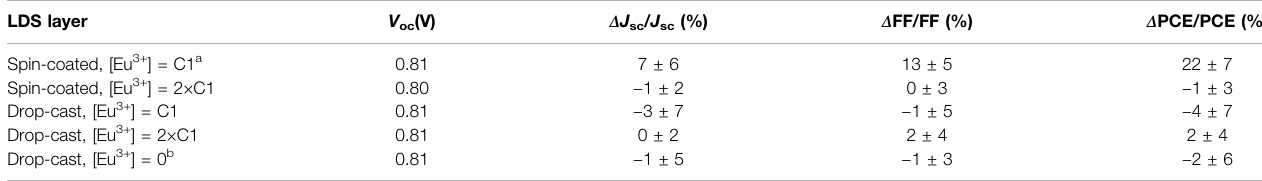
TABLE 1 | Relative variations in performance parameters of glass/ITO/PEDOT:PSS/PTB7-Th:ITIC/CA/Al devices with dU6Eu LDS layers deposited under different conditions in comparison with control devices without LDS. LDS layer V oc (V) Δ J sc / J sc (%) Δ FF/FF